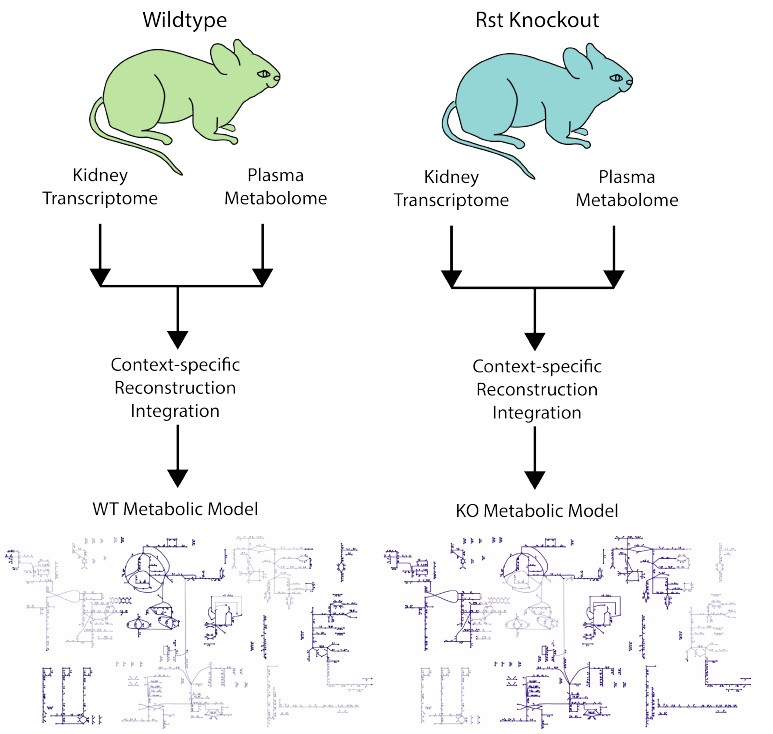
Figure 4. Renal transcriptomic data in conjunction with plasma metabolomic profiles of WT and Urat1/Rst KO mice were used to build in silico models of metabolism. Comparisons between the WT and KO states were then performed through assessment of differences in the content of the models (i.e., differences in the composition of the WT versus KO metabolic networks) as well as their functional states (i.e., comparison of the different attainable flux states through simulation and comparison of the feasible steady state flux distributions).